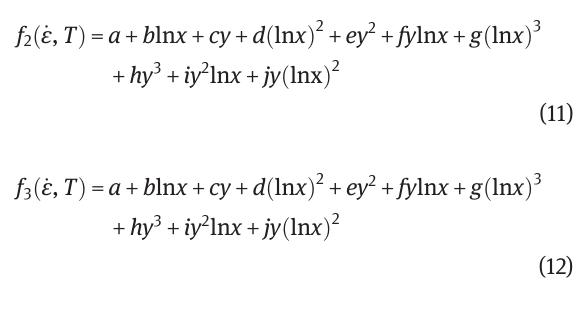
evaluate the reliabilities of fitting surfaces and it shows that the fitting equations have a high relativity.